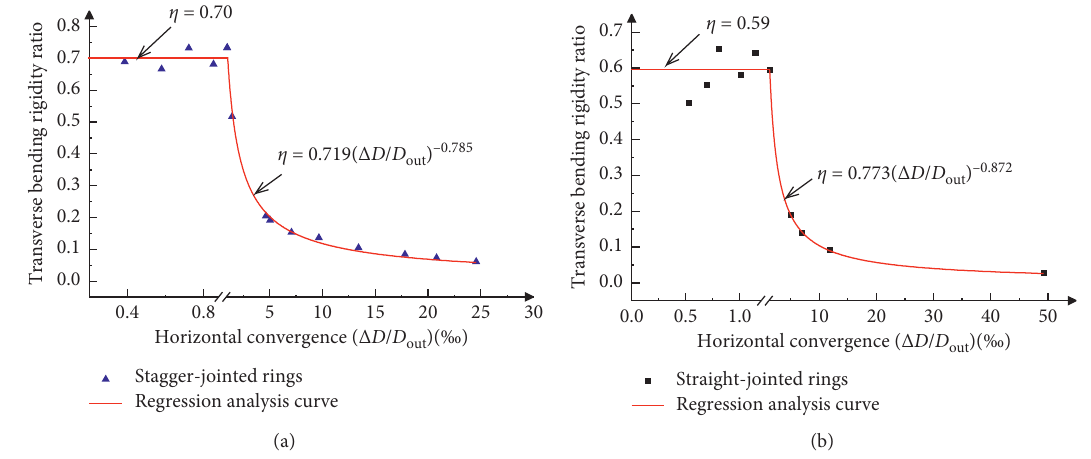
Figure 17: Regression analysis result. (a) Stagger-jointed rings. (b) Straight-jointed segment rings’ horizontal diameter from mileage ZDK18 + 604 ∼ ZDK18 + 754. As shown in Figure 21, the diameter convergence of segment rings was significantly increased after two surcharging accidents, and the maximum horizontal diameter convergence reaches 8.85‰ at No. 50